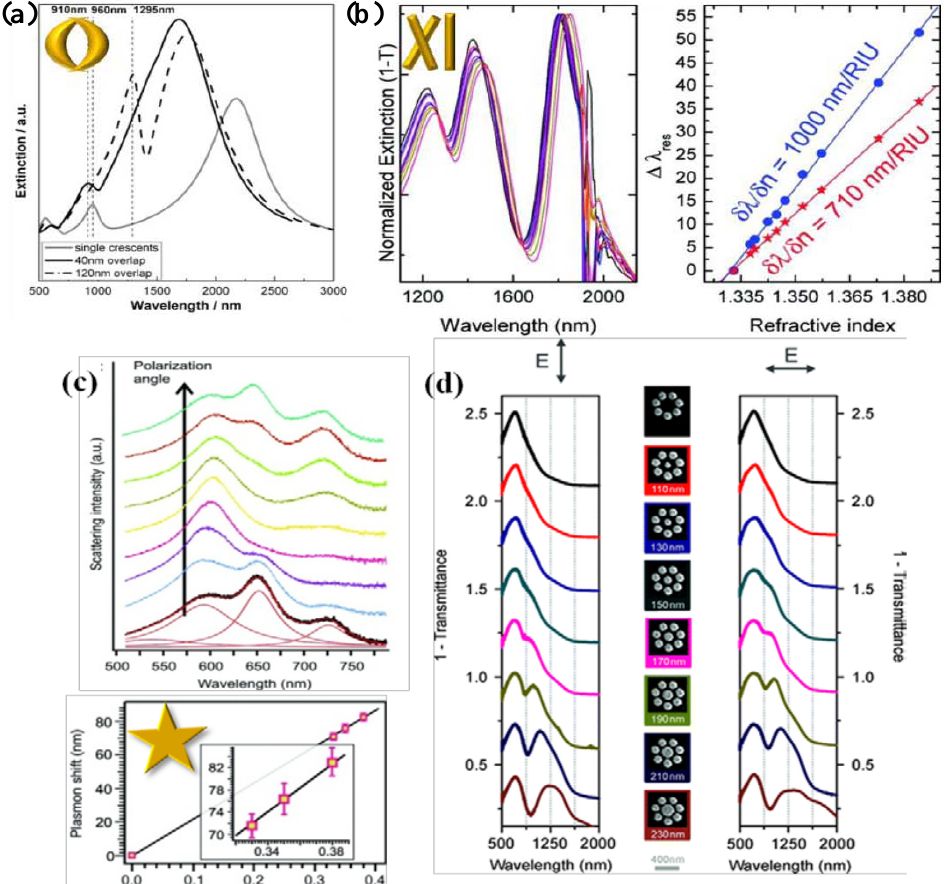
Figure 10. Various nanostructures as the candidate of LSPR nano biosensor. (a) Ultraviolet-visible-near-IR extinction spectra of stacked double crescents; (b) extinction spectra and refractive index sensing results of XI cavity; (c) light scattering spectra of a single gold nanostar and average spectral shift of nanostars resonances as a function of surrounding refractive index; (d) extinction spectra of plasmonic octamers depending on the center particle diameter for vertical and horizontal polarizations and (e) schematic of the measurement system for LSPR sensing. Figures are reprinted with permission from [28,36-38]. (a) Copyright (2011) American Chemical Society (b) Copyright (2011) American Chemical Society (c) Copyright (2010) American Chemical Society (d) Copyright (2011) American Chemical